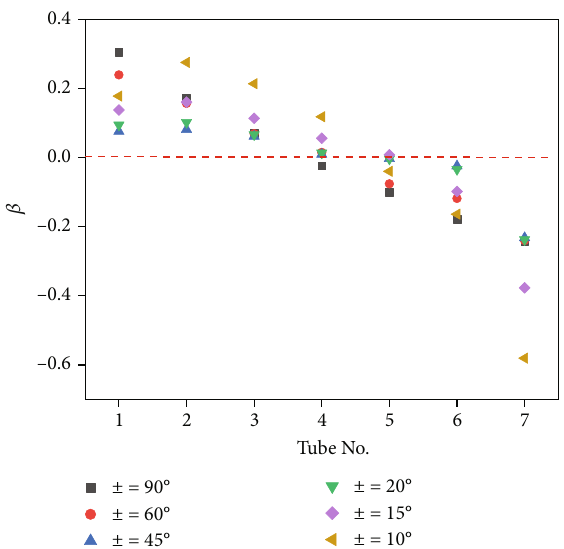
Figure 10: The pressure drop of each channel with di ff erent α values.